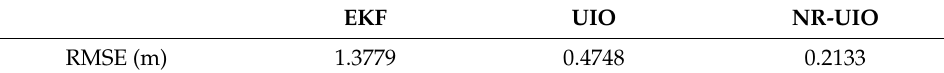
Figure 6. The overall trajectories estimated using only the UWB-Inertial odometry (UIO) and the proposed NLOS-robust UWB-Inertial odometry (NR-UIO). Table 2. The root mean square errors of EKF, UIO, and NR-UIO compared with GT.